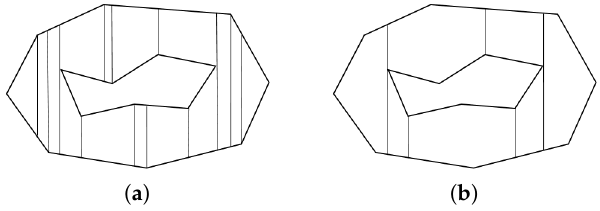
Figure 6. Comparison between ( a ) the trapezoidal decomposition and ( b ) the method proposed in